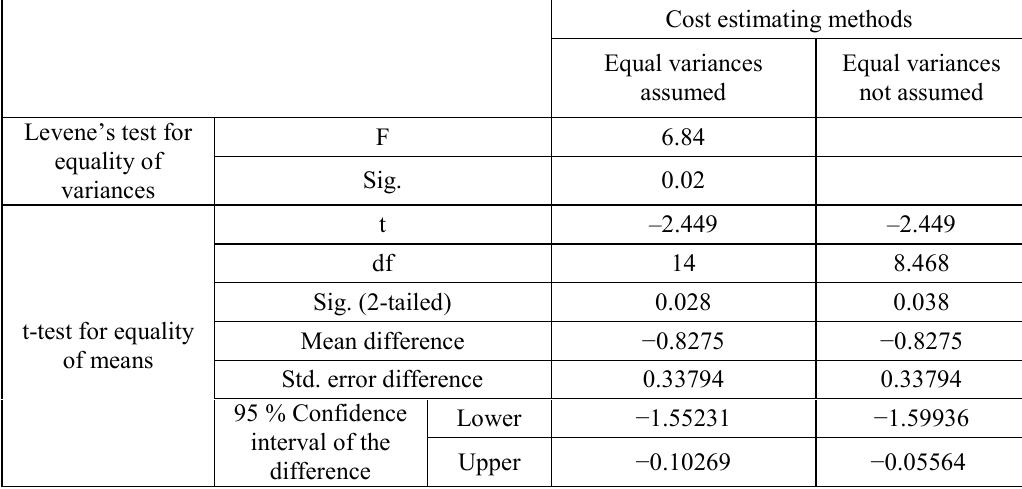
Table 4. Variance and Independent Samples Test of the Level of Expertise in Cost Estimating Methods between Valuers & Quantity Surveyors (developed by the